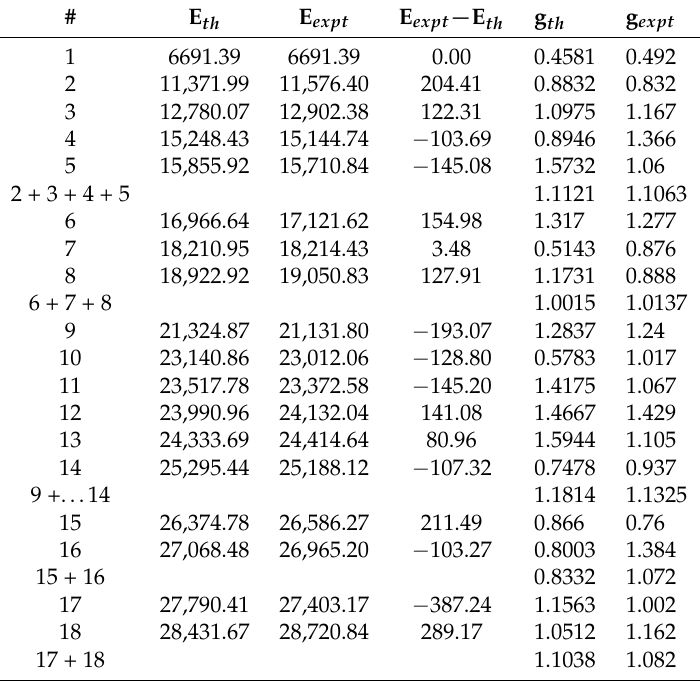
Table 2. Energies (cm − 1 ) and g-factors for optimized parameters presented in Table 1 for J = 1.5 odd states. The experimental energies and g-factors are taken from NIST database